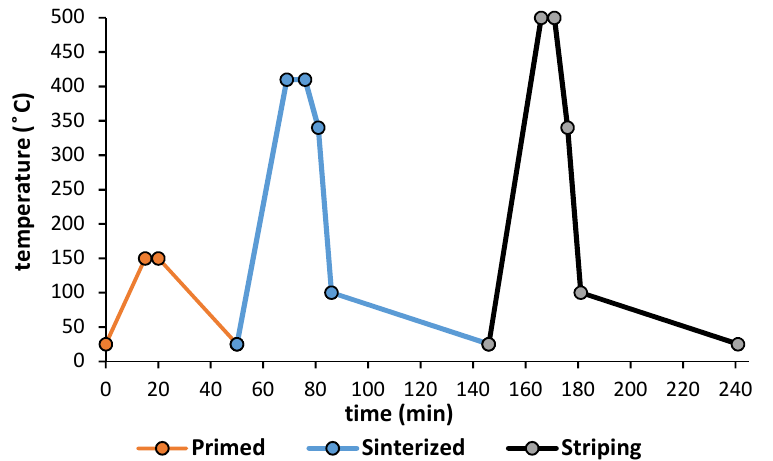
Figure 1. Thermal cycle 1 applied in substrates EN AW 5251, EN AW 5754, and DX51D AS120 B.